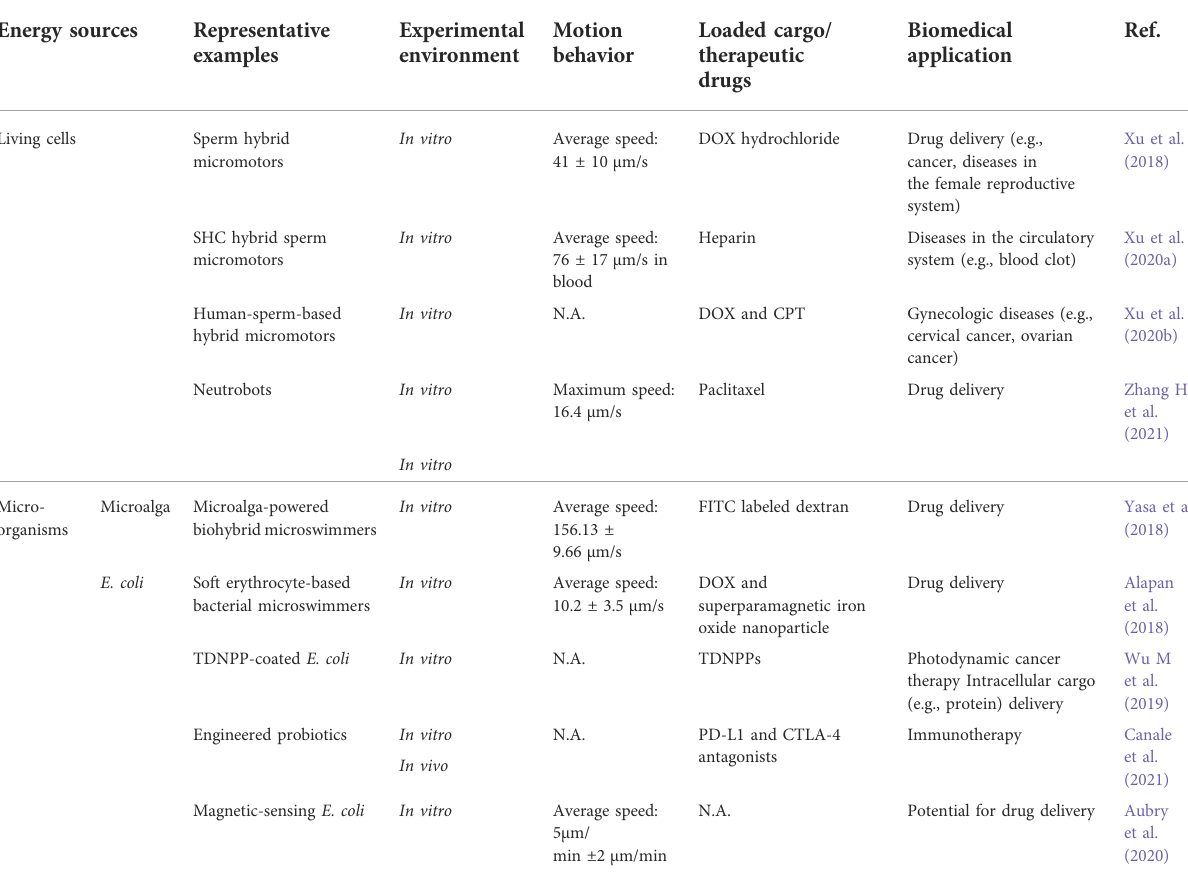
TABLE 3 Biohybrid MNRs for motile-targeting drug